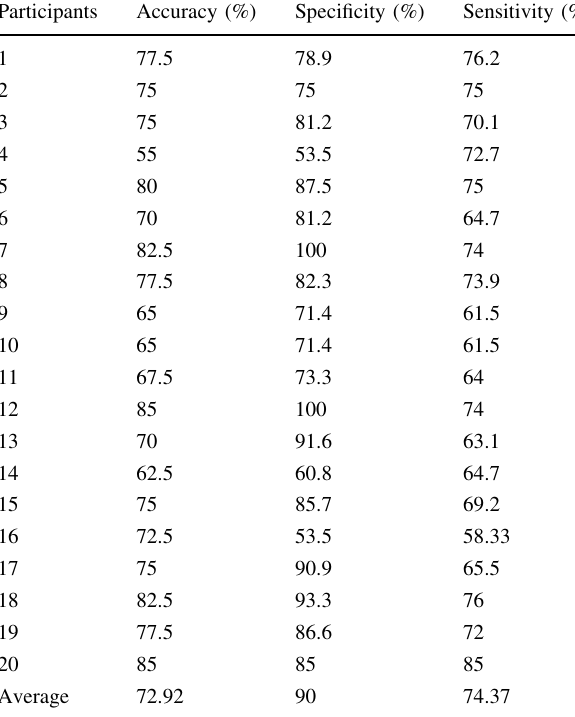
Table 3 Classification of emotions for each participant using k